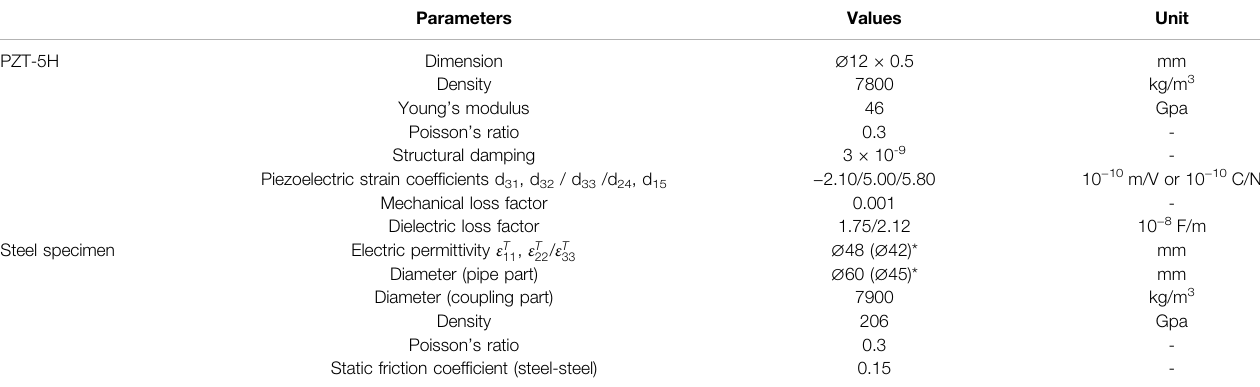
TABLE 2 | The parameters of the specimen and the PZT